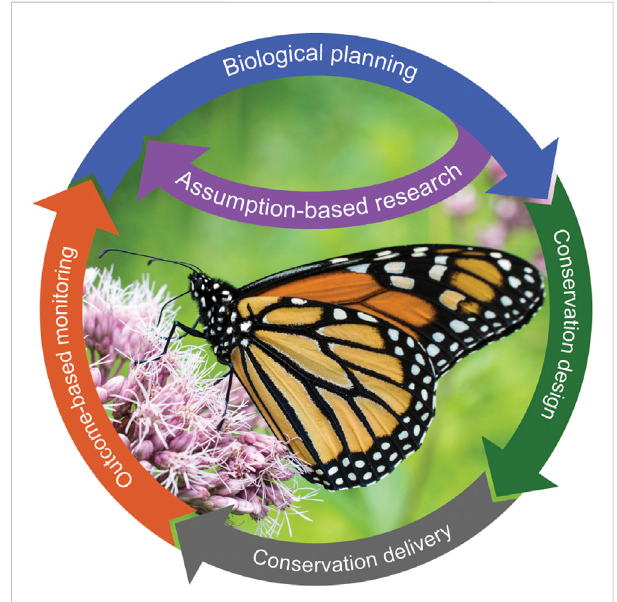
FIGURE 5 Elements of Strategic Habitat Conservation. SHC is an adaptive management framework developed by the USFWS. The MCSP primarily focused on Biological Planning, Conservation Design, and Outcome-based Monitoring. Monarch photograph by E. Weiser,